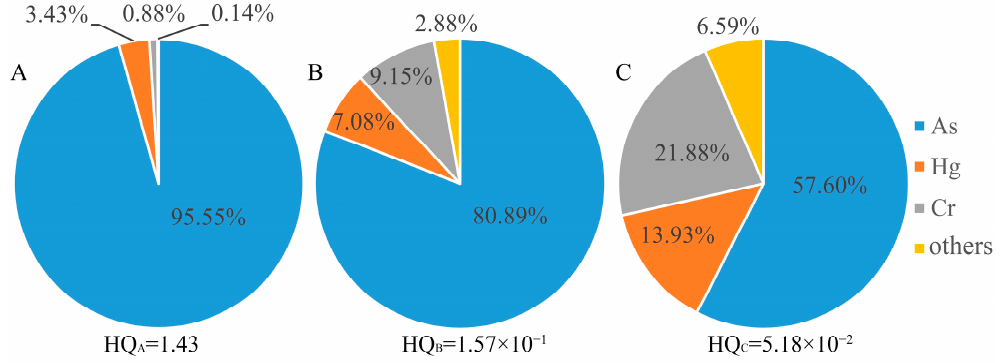
Figure 4. Noncarcinogenic risk contribution rate for oral intake of heavy metals in soil. A, B and C represent area A, area B and area C, respectively.